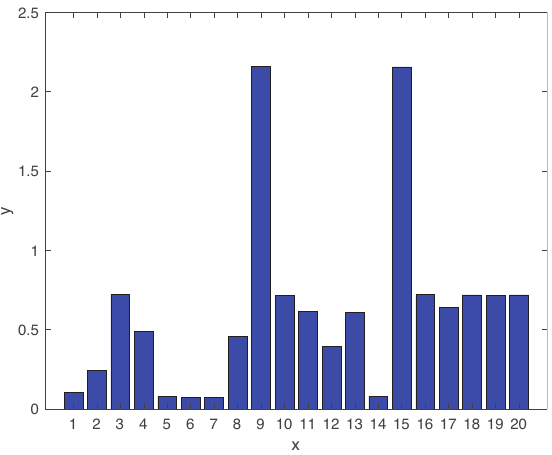
Figure 8. Expected fault detection delay of all types of